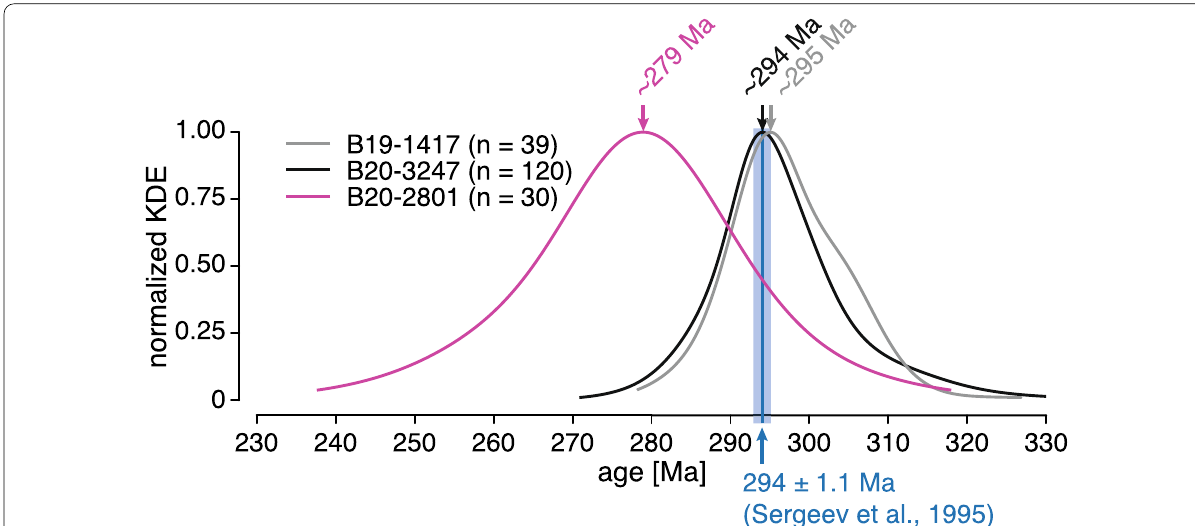
Fig. 17 Kernel density estimates (KDE, Vermeesch, 2012) and approximate peaks of 206 Pb / 238 U -ages determined for zircons of a RG1 sample (B19-1417), a RG2 sample (B20-3247), and a QB-SZ sample (B20-2801). n -values in brackets correspond to number of considered ages (data used for the mean calculation and age range definition in Figs. 12f and 15e, and data corresponding to the 252–303 Ma age range in Fig. 16f). KDE curves are normalized to a maximum value of